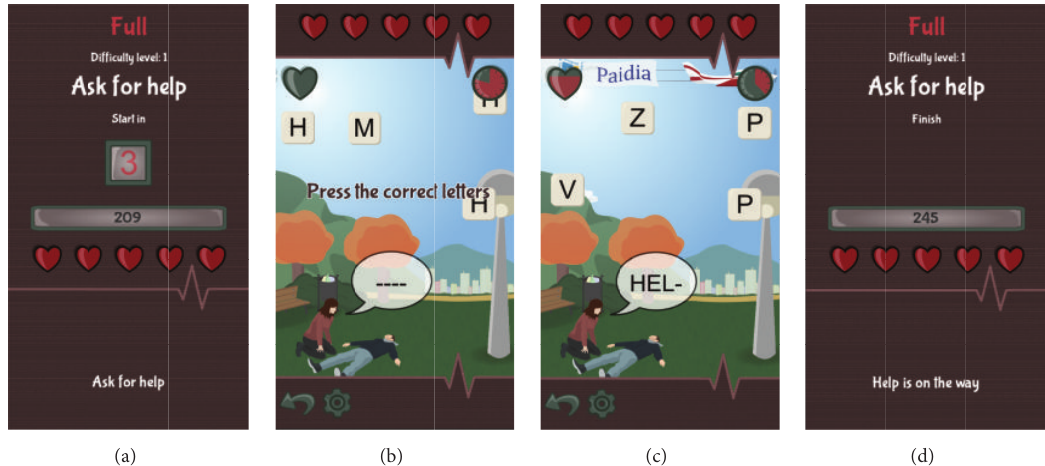
Figure 6: Screens of the Ask for Help mini game. (a) Init screen with game instructions. (b) Scene with the empty balloon and falling letters. (c) Scene with some of the help letters completed. (d) Final screen with the game score and the message that help is on the way.